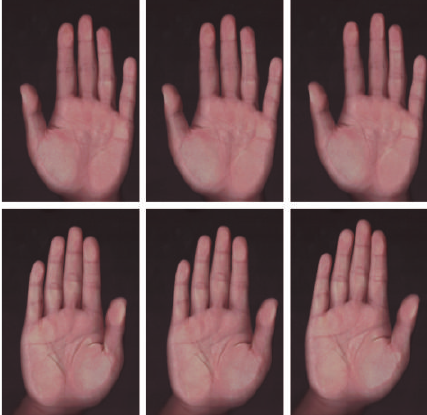
Figure 5: Palmprint images of both hands from